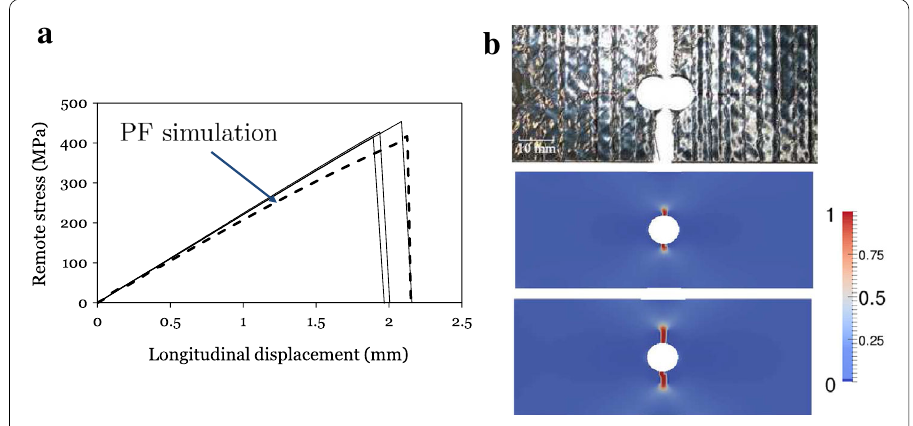
Fig. 5 a Experimental and numerical remote stress vs. displacement curves; b experimental–numerical crack path for open-hole specimens